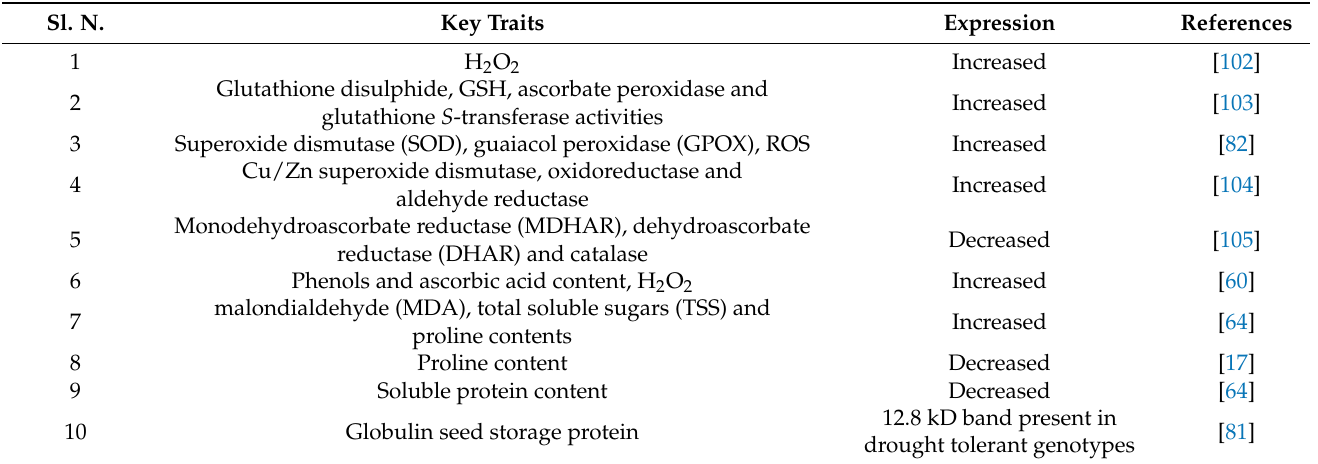
Table 3. Biochemical responses modulating drought tolerance in mungbean. Sl.